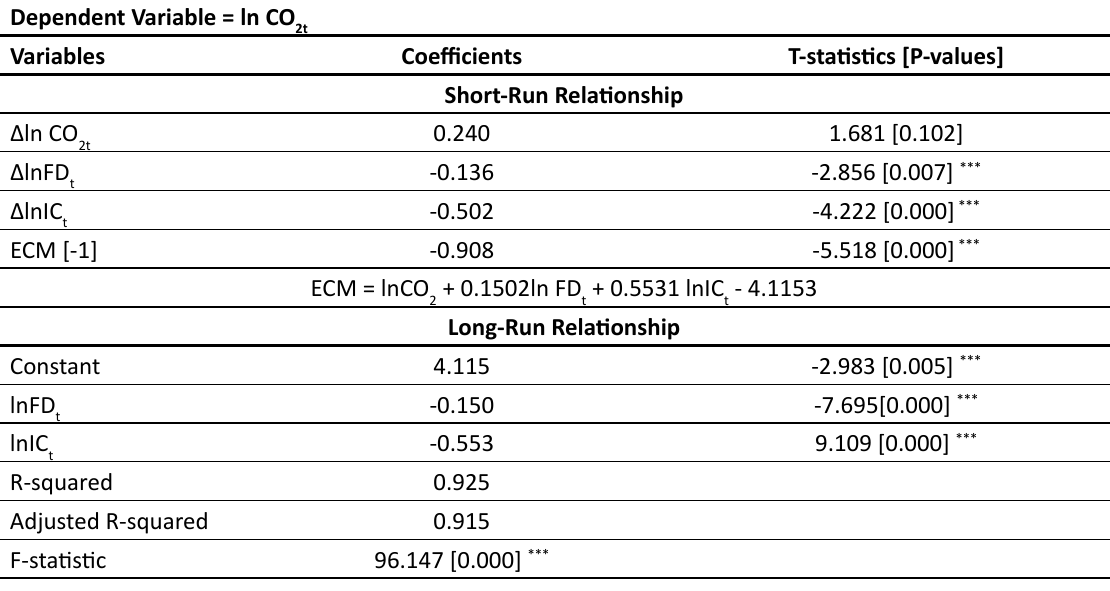
Table 6: ARDL Short and Long-Run Results